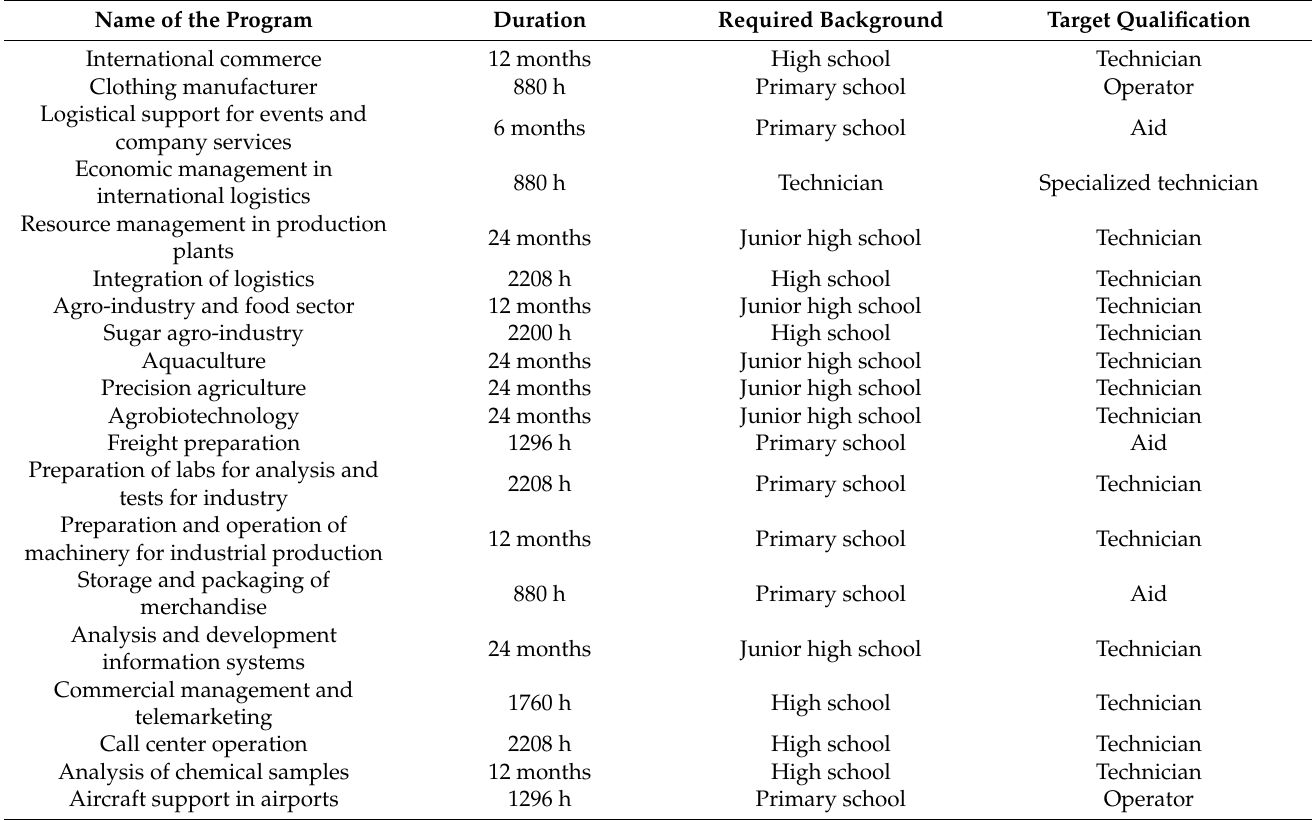
Table 2. SENA Training Programs amenable to Virtual